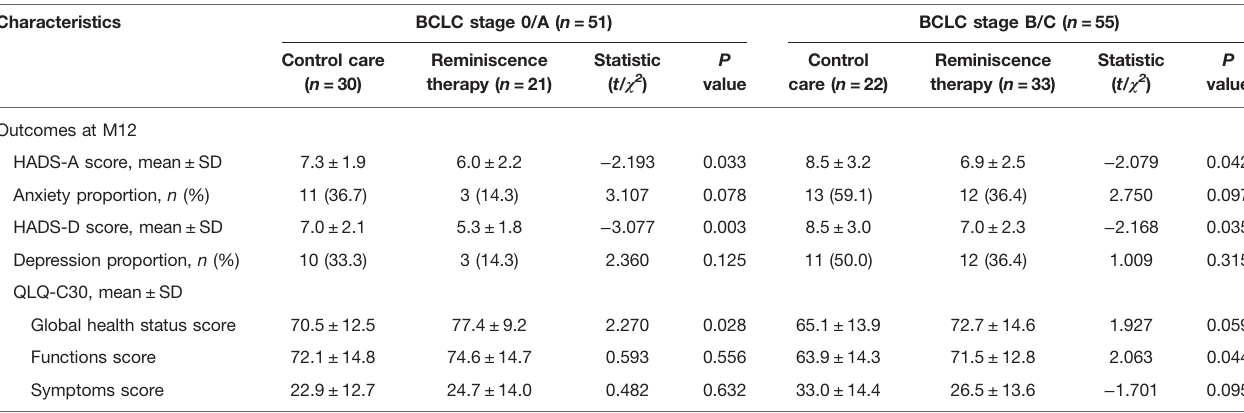
TABLE 2 | Subgroup analyses by BCLC